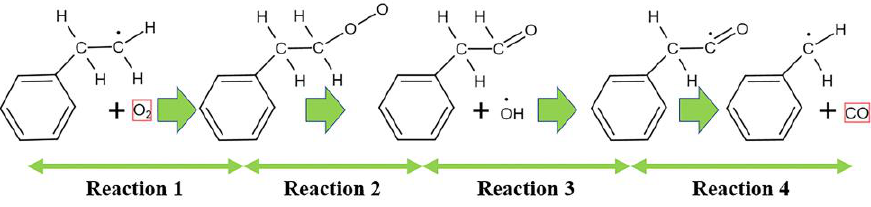
Figure 8. Group change during heating process.